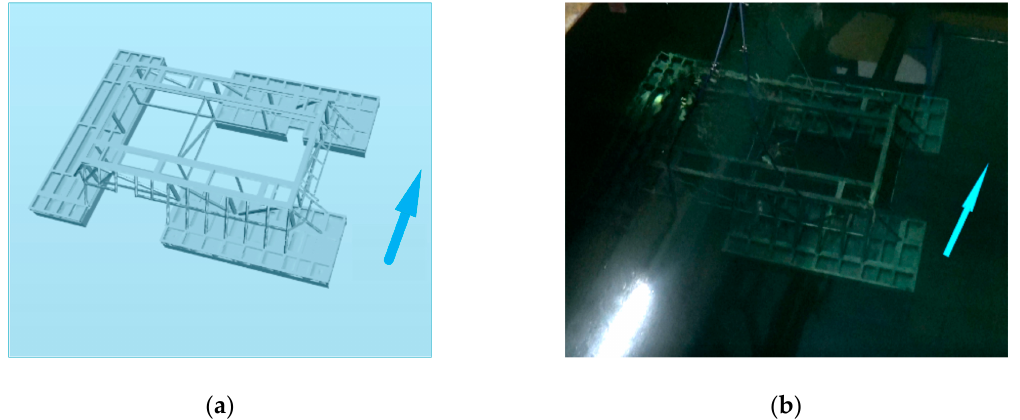
Figure 11. Stable towing state in Case 4: ( a ) Attitude of the module in the simulation, ( b ) Attitude in the experiment.